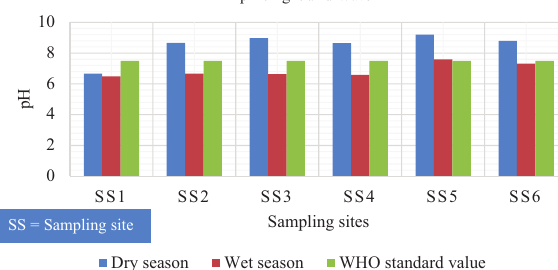
Figure 5 . Seasonal variation in pH of groundwater quality in the study